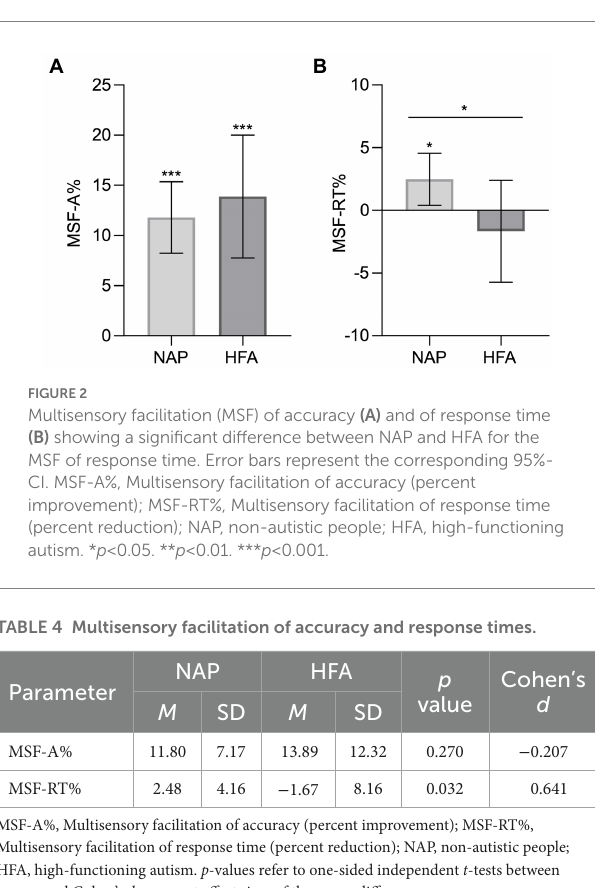
MSF-A%, Multisensory facilitation of accuracy (percent improvement); MSF-RT%, Multisensory facilitation of response time (percent reduction); NAP, non-autistic people; HFA, high-functioning autism. p -values refer to one-sided independent t -tests between groups and Cohen’s d represent effect sizes of the group